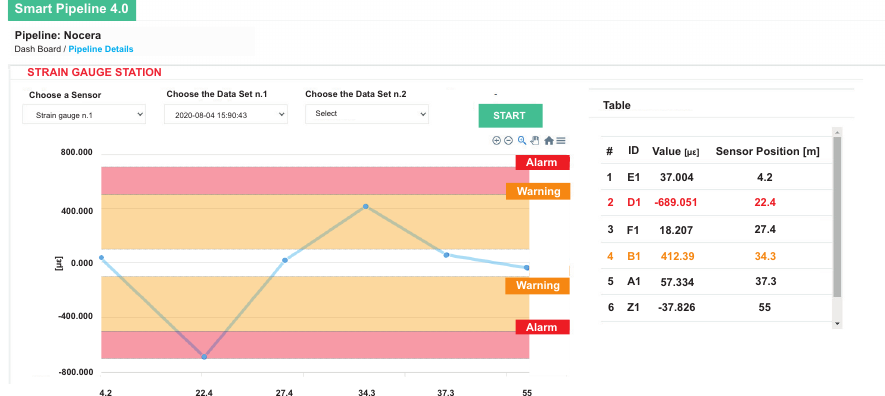
Figure 17. Web application-Pipeline monitoring